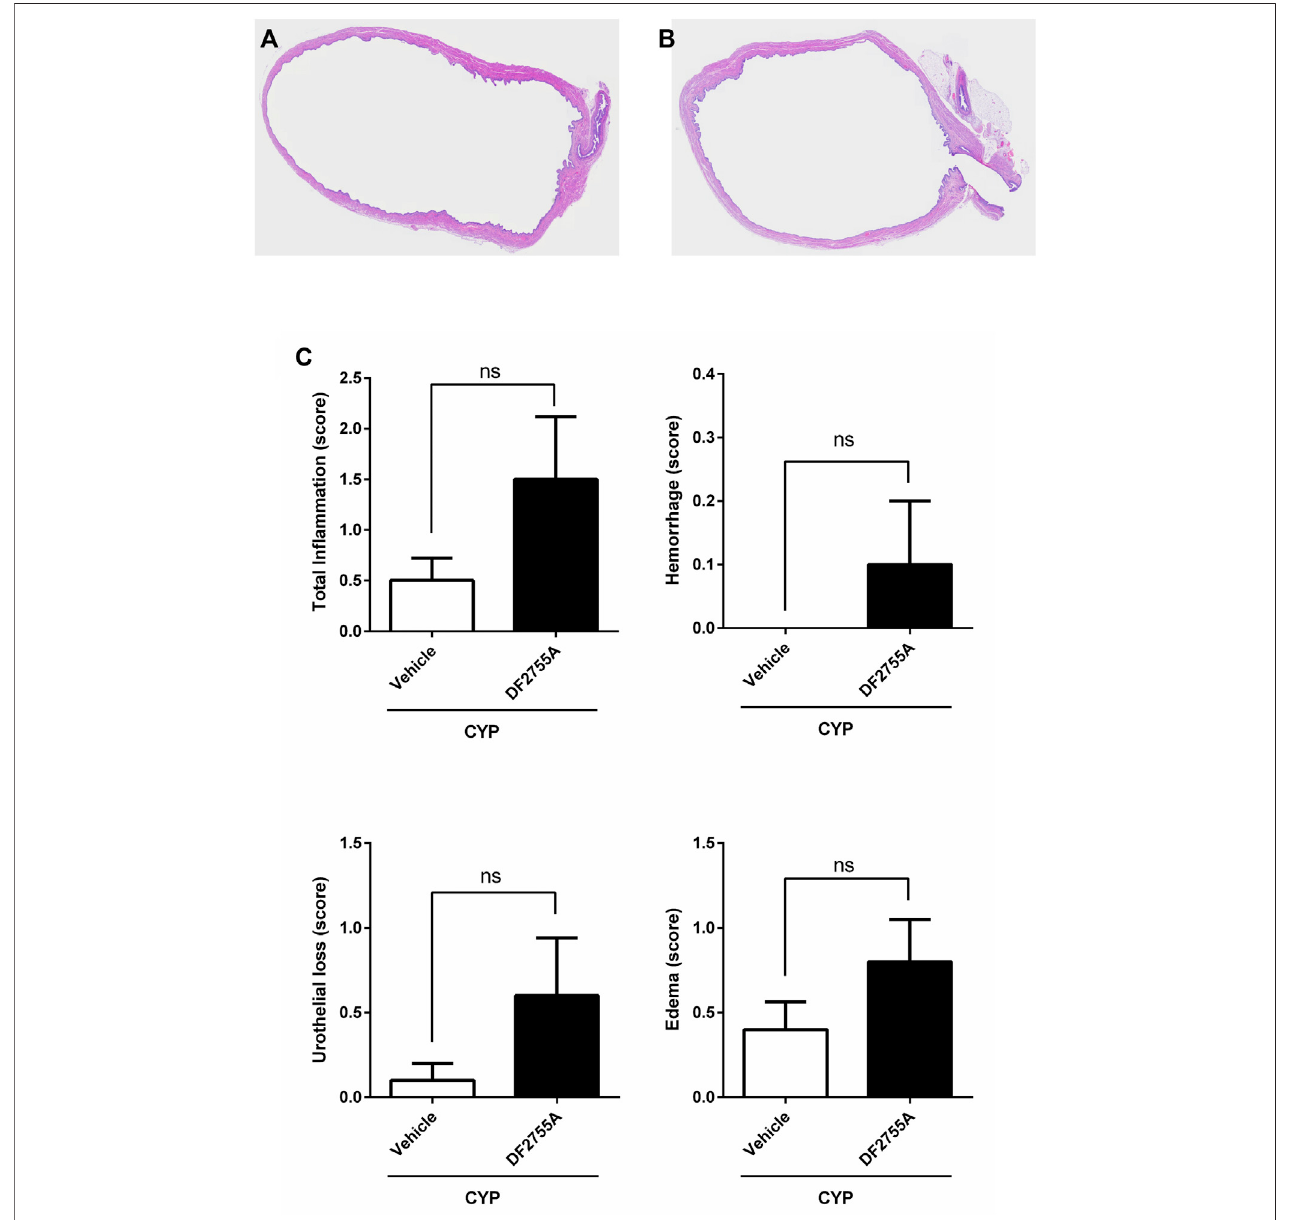
FIGURE2| ChronicCYPadministrationandDF2755Atreatmentdidnotaffecturinarybladderhistology.RatswereorallytreatedwithrepeatedvehicleorDF2755A (20 mgkg − 1 12 hbeforethe fi rstCYPinjection+7 mgkg − 1 twicedailyfor7 days)administrations.After24 hofthelastCYPinjection,urinarybladderswereremovedand processedasdescribedinMethods.Sectionsofhematoxylinandeosin-stainedbladderpiecesfromCYP- (A) andCYP+DF2755A-treatedanimals (B) areshown.Scale bar, 200 µm. Total in fl ammatory score, urothelial loss (score), hemorrhage (score), and bladder edema (score) in CYP rats treated with vehicle or DF2755A (C) . Results are expressed as mean ± SEM ( n = 10 per group). ns p > 0.05, Mann – Whitney